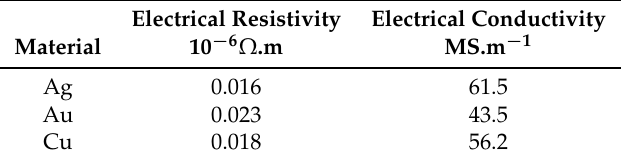
Table 1. Electric characteristics of tested materials at a temperature of 20 degrees Celsius